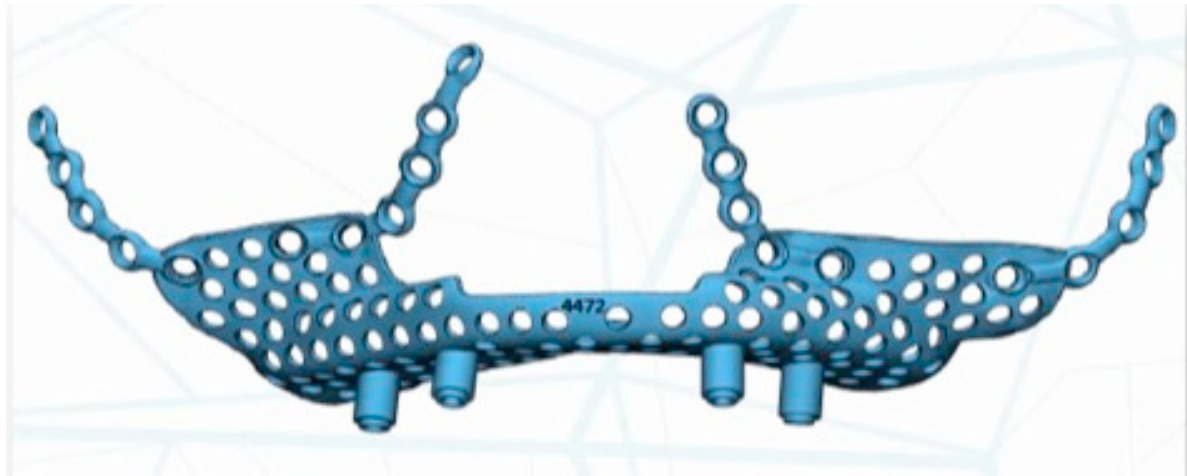
Figure 4. A 3D proper design of the subperiosteal implant.